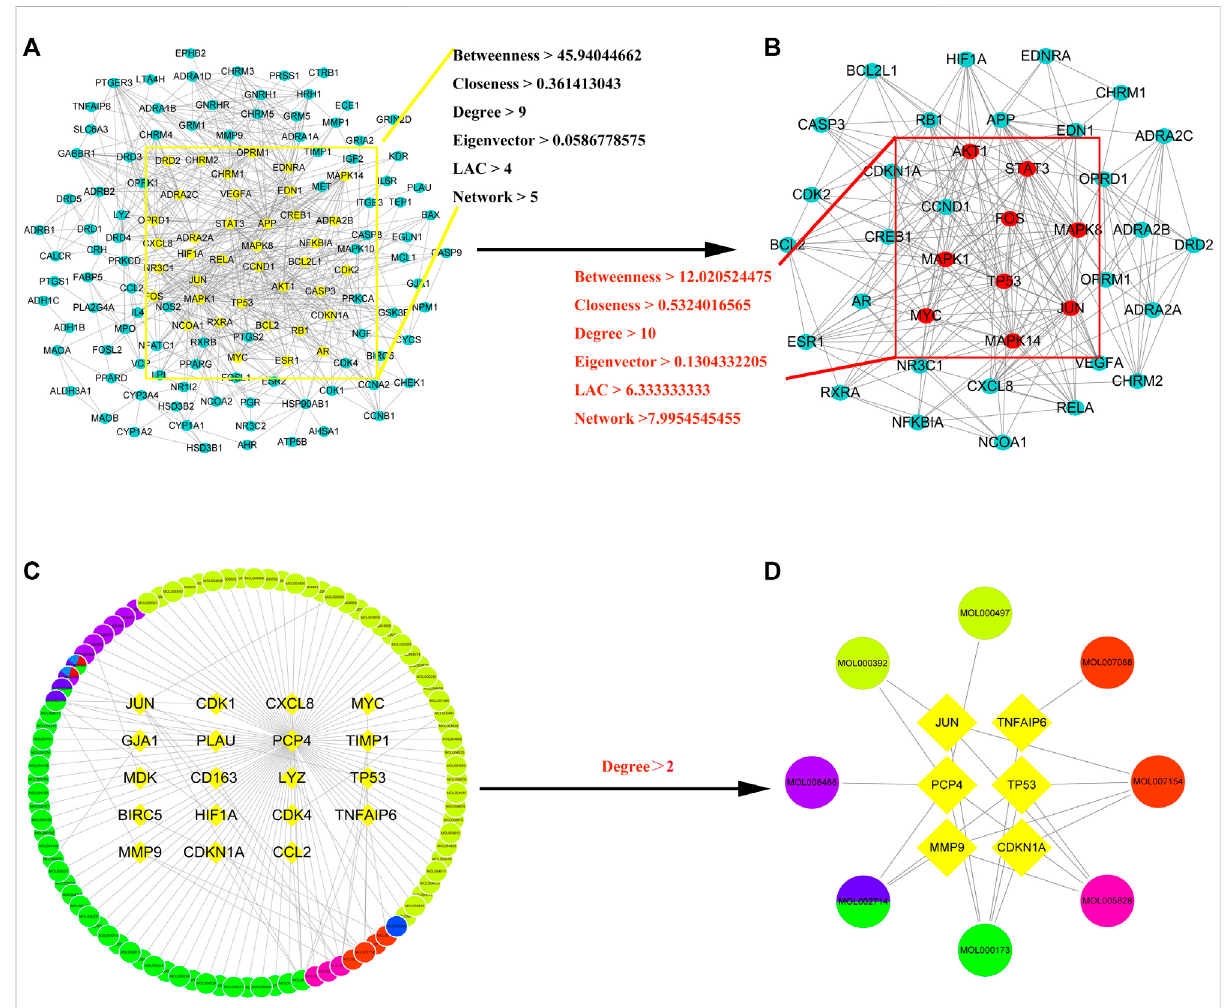
FIGURE 4 XLDproteininteractioncorenetworkANDGBMdrug-disease-targetnetworkforXLDtherapy. (A) Interactionnetworkof143drugtargetgenes, theyellowovalindicatesthe38coregenesin (A) . (B) The38coredrugtargetgeneinteractionnetworkin (A) .Theredovalindicatesthe fi nalninecore genes. (C) XLD-GBM-target network. (D) XLD-GBM-target core network. Common targets for drugs and diseases are indicated by a diamond and drugsareindicated bycircles(yellow for danshen,blueforgancao, greenfor gouteng,pinkfor yanhusuo, redforChenPiandmixed coloursfor multiple drugs). XLD, Xiaoliu Decoction; GBM, glioblastoma